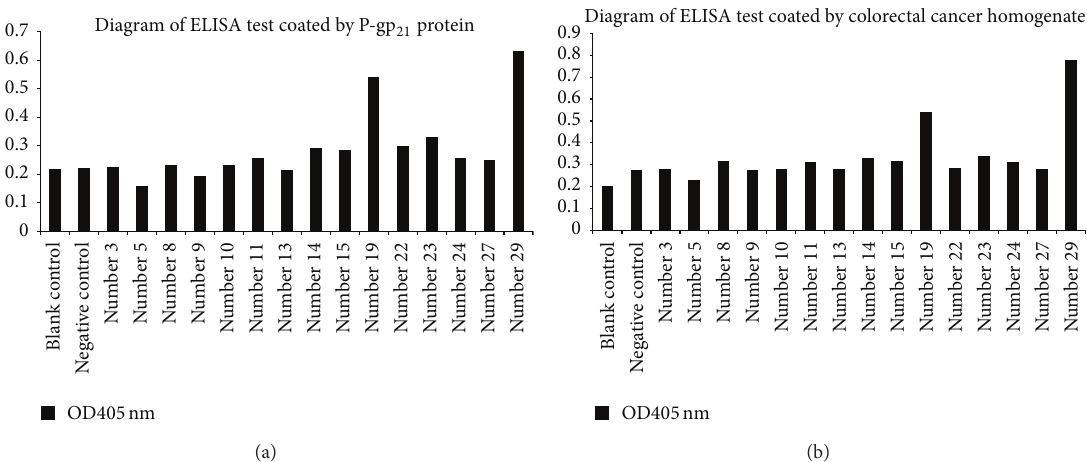
Figure 6: The optimal clone was checked by ELISA. (a) Diagram of ELISA (plate wells were coated by P-gp 21 protein); (b) diagram of ELISA (plate wells were coated by colorectal cancer homogenate). The 𝑥 -axis shows the clone number; the 𝑦 -axis shows the ratio of the ELISA signal (A450) in the presence of 1 𝜇 g/ 𝜇 L purified P-gp 21 and 2 𝜇 g/ 𝜇 L human colorectal cancer homogenate.